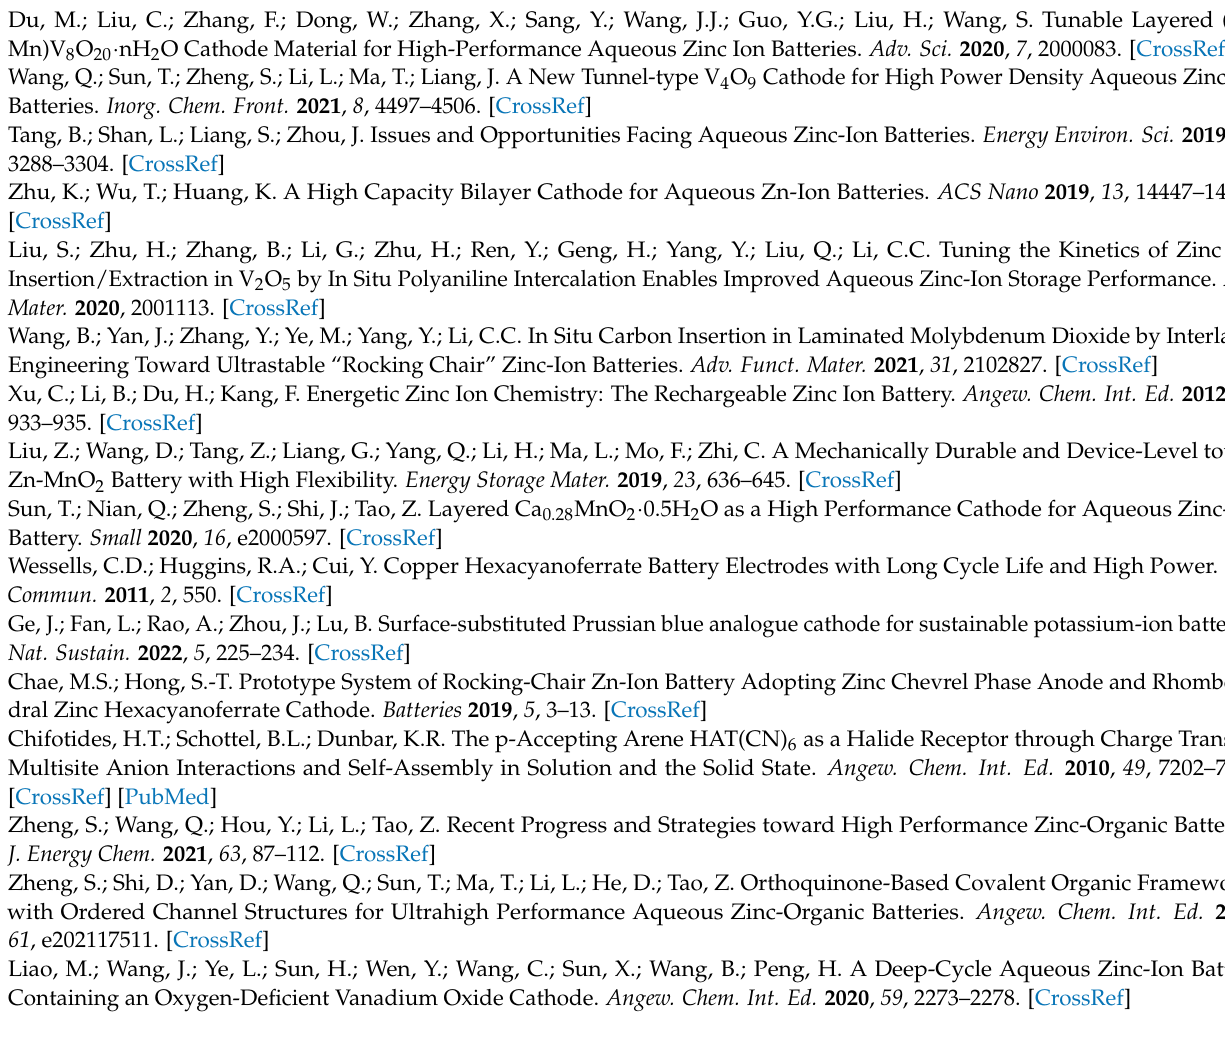
Figure S4: O 1s XPS spectrum of KNVO in different states; Figure S5: SEM image of KNVO in initial (S4a), discharged (S4b) and charged state (S4c), repectively; Figure S6: N 1s XPS spectrum of NVO in different states; Figure S7: Crystal structural illustration of KNVO. Table S1: The comparisons of our work and previous reports; Table S2: Element distribution and atomic percentage of KNVO and NVO in discharged and charged state,